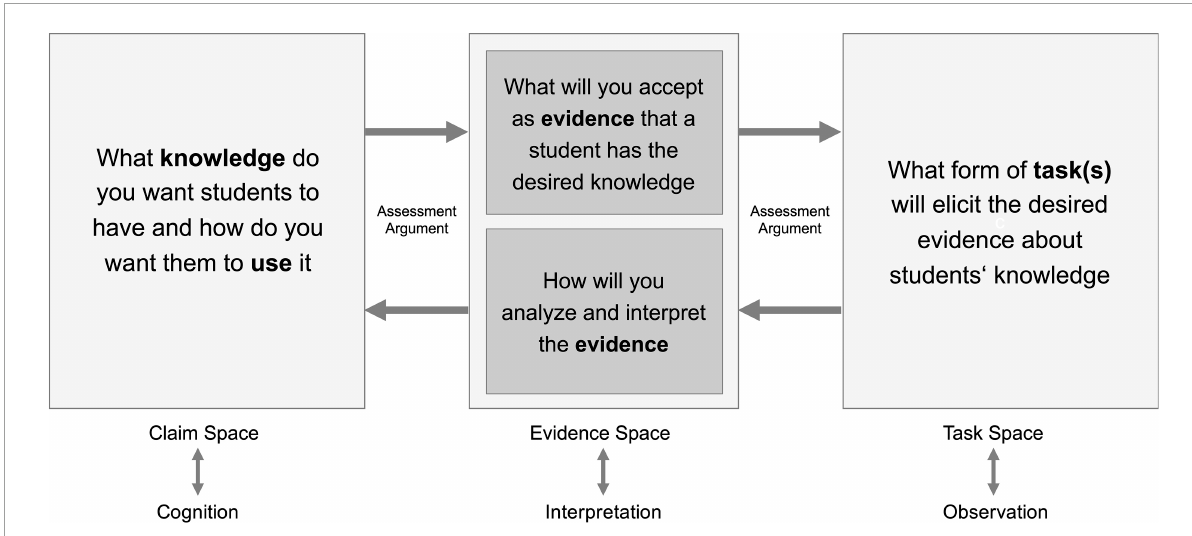
FIGURE2 Simplified representation of evidence-centered design, adopted from Pellegrino et al. (2015).